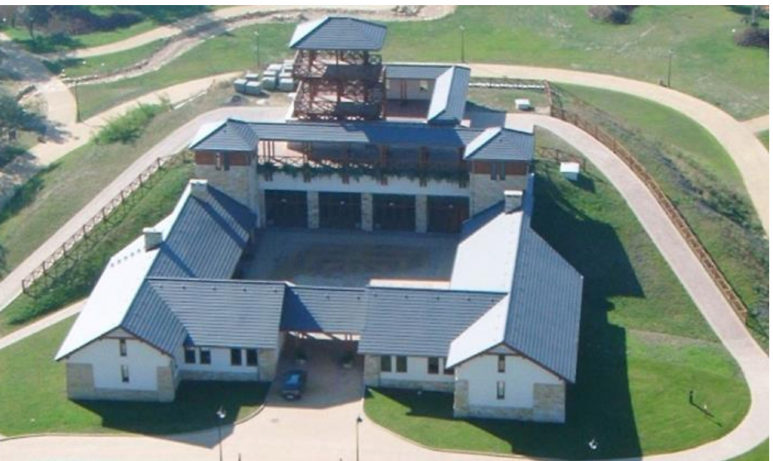
Figure 1. View of the analysed building of the Silesian Botanical Garden, Mikoł ó w, Poland (source: phot. of Janusz Moczulski, 2013); available thanks to 2013 Paweł Kojs’